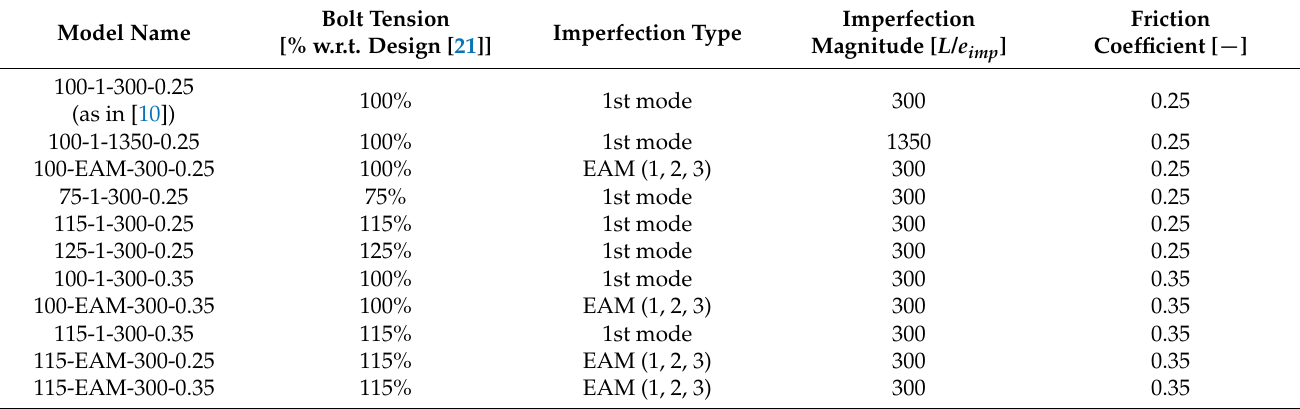
Table 2. Analyzed models of L80x8 beam section. The model codename refers to bolt tension (ratio to Eurocode 1993-1.8 design value), applied imperfection mode, imperfection magnitude, and friction